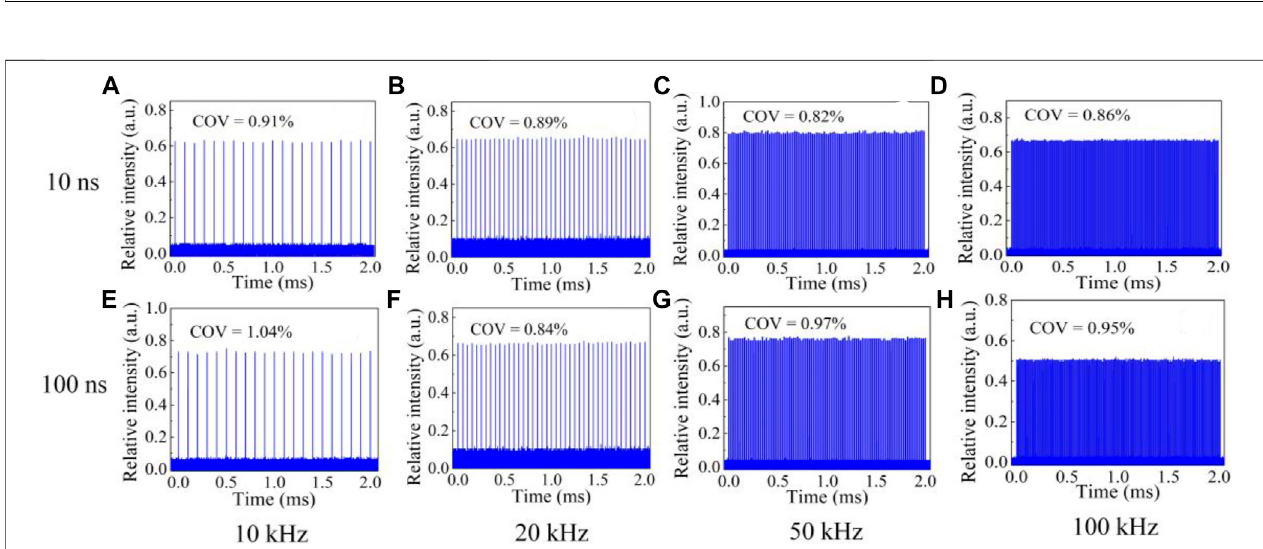
FIGURE 3 | Output single-pulse energy versus absorbed pump power. (A) For electric signal input with single-pulse duration of 10 ns. (B) At modulation signal input with a single pulse width of 100 ns.